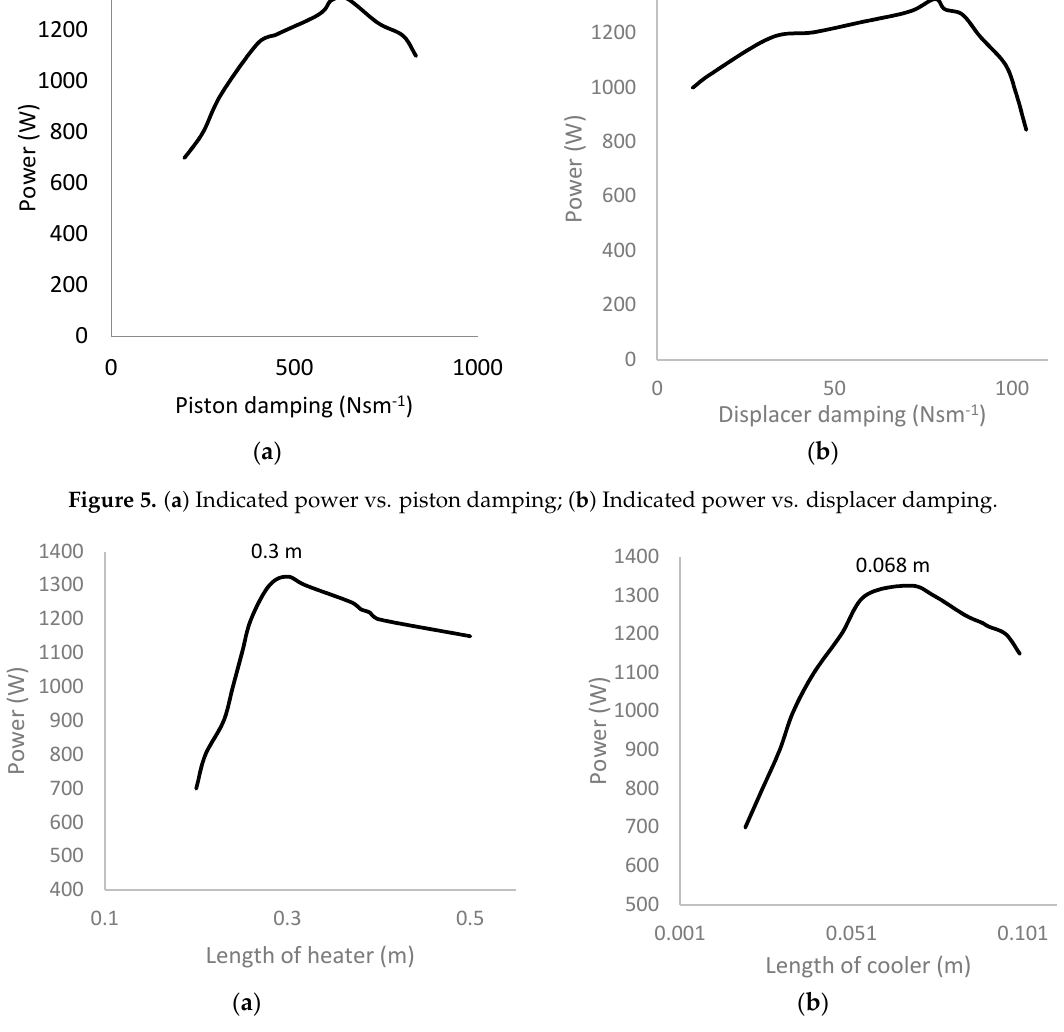
Figure 6. ( a ) Indicated power vs. length of heater; ( b ) Indicated power vs. length of cooler.